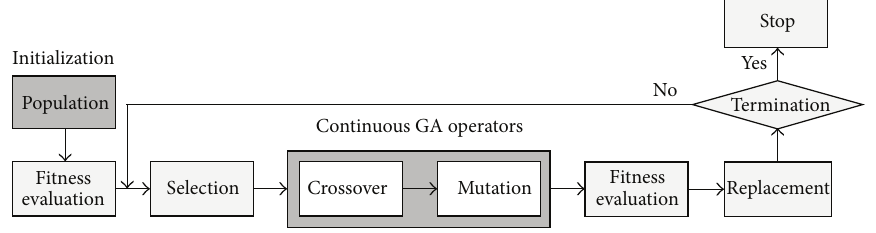
Figure 1: The flowchart of the life cycle of continuous